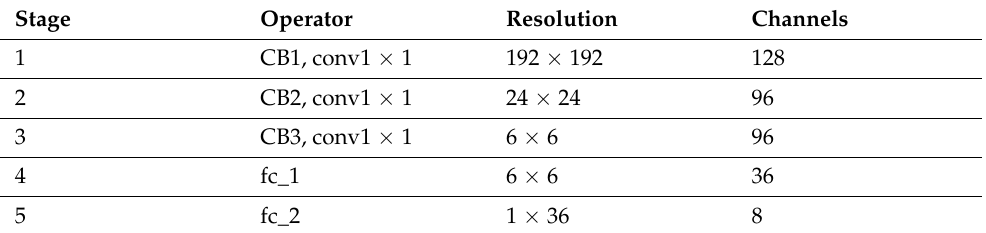
Table 3. Model B3.